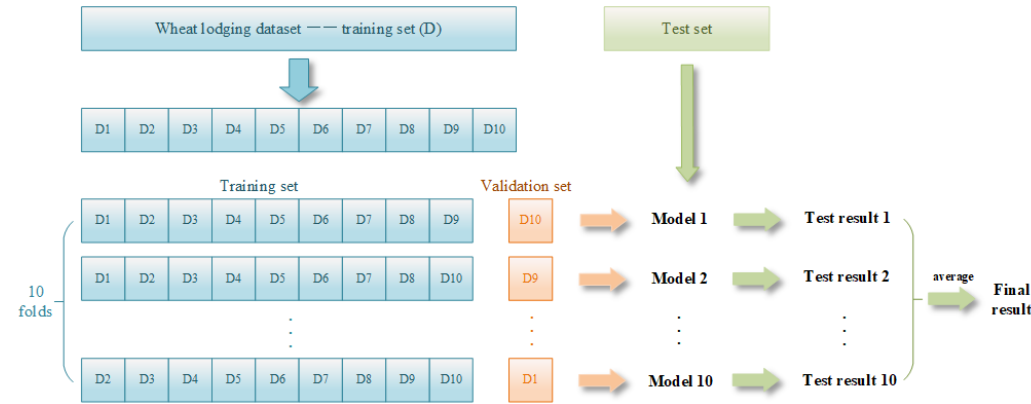
Figure 7. Workflow of k-fold cross validation.